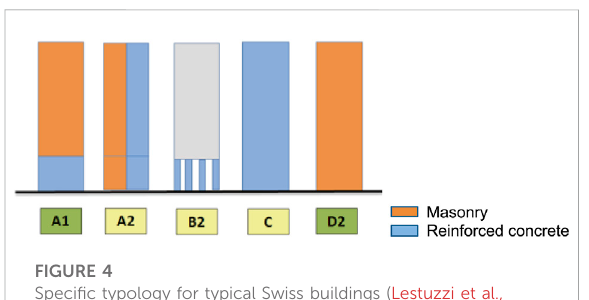
FIGURE 4 Speci fi c typology for typical Swiss buildings (Lestuzzi et al., 2017)